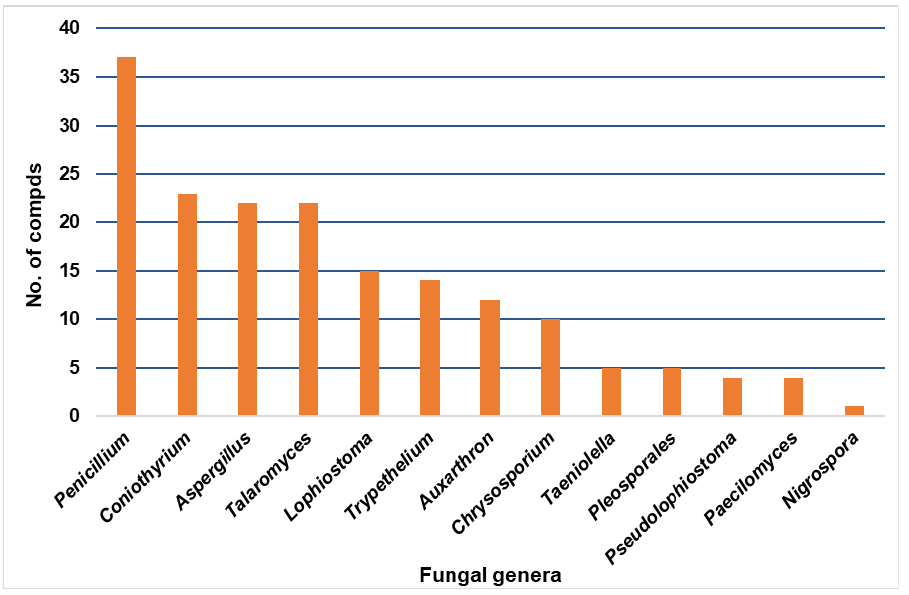
Figure 24. The numbers of phenalenones isolated from the different fungal genera.